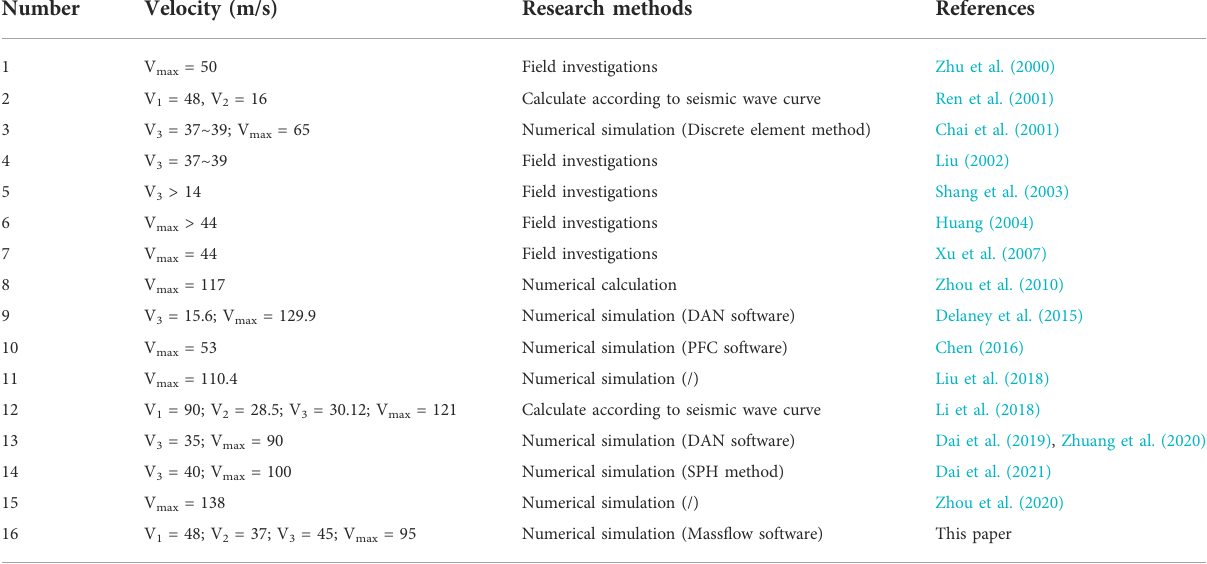
TABLE 4 Sliding velocity statistics research results of the Yigong